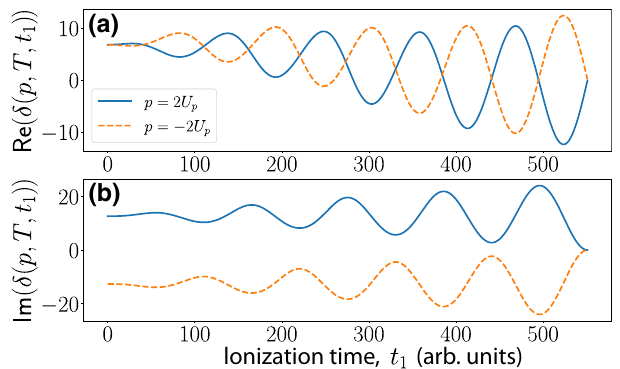
FIG. 6. Real (a) and imaginary (b) parts of the shift of the fundamental mode δ( T , t 1 , ω k , p ) for values of the canonical (cid:21) (cid:21) momenta p = 0.93 U p (blue solid curve) and p = − 0.93 U p (orange dashed curve). The different behaviors obtained for positive and negative momenta are a consequence of the carrier- envelope phase (CEP) (which is the phase between the carrier wave and the pulse envelope) of the employed laser field, such that a change in π of this phase interchanges the behavior obtained for positive and negative